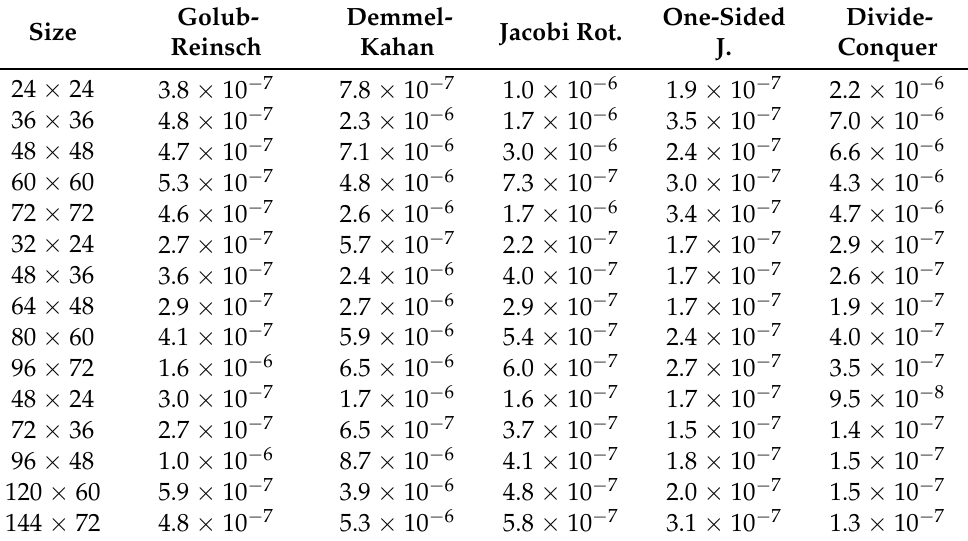
Table 6. Average errors of SVD algorithms on Cortex-M4F vs. MATLAB built-in.